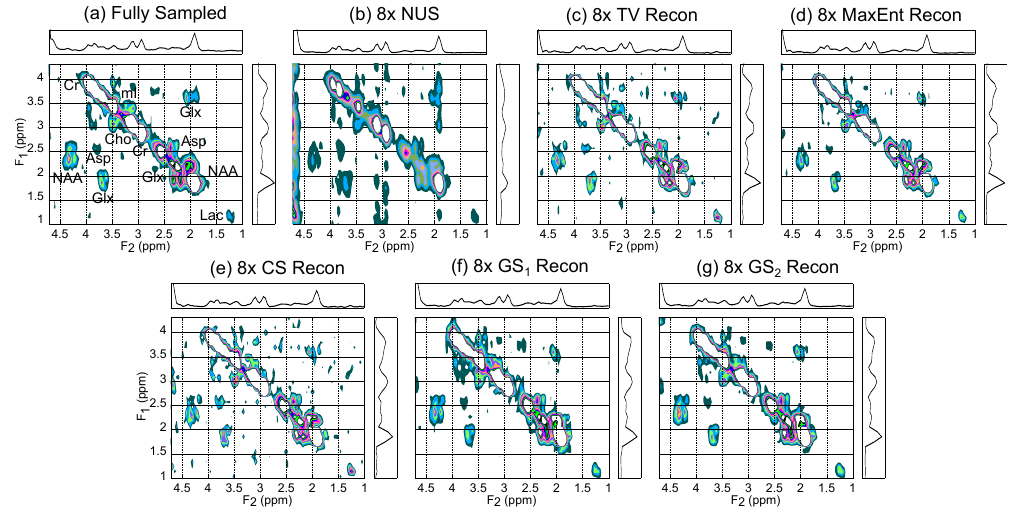
, ( g ) 8 × GS reconstructions. 1 2